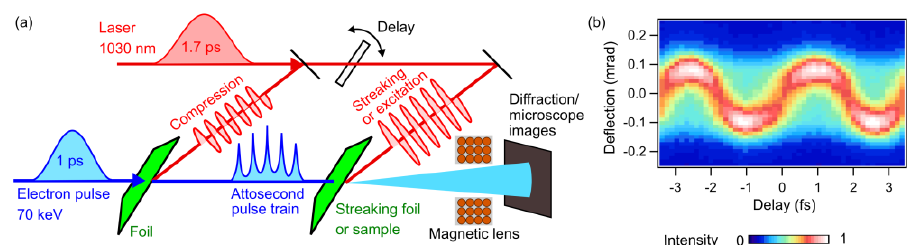
Fig. 1. Attosecond electron pulse trains and applications. (a) Attosecond electron-beam control and microscopy/diffraction demonstrations. (b) Streaking characterization of attosecond electron